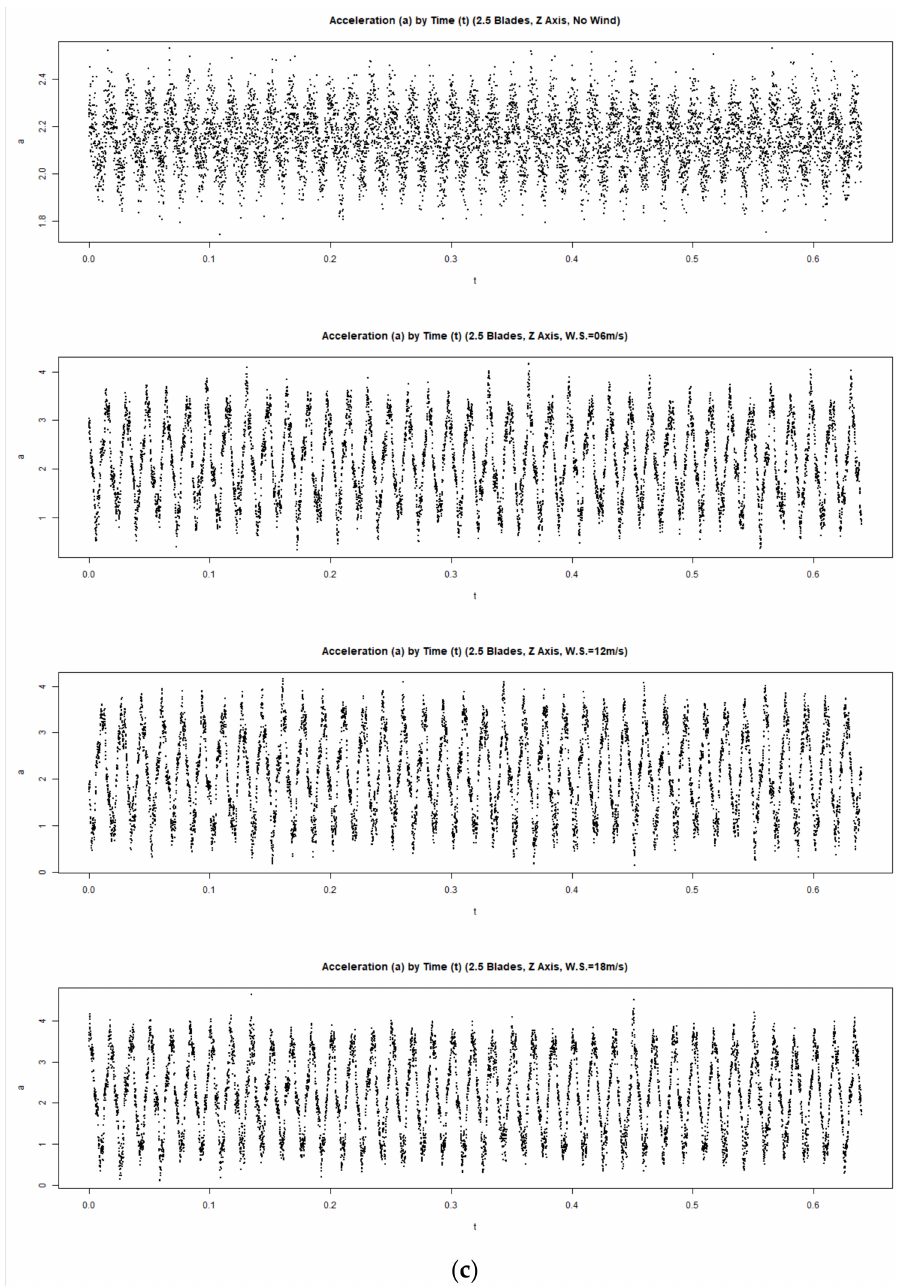
Figure A2. Acceleration signals recorded for the 2.5-blade (partially broken) turbine. ( a ) Data recorded along the X axis with different wind-speeds imposed. ( b ) Data recorded along the Y axis with different wind-speeds imposed. ( c ) Data recorded along the Z axis with different wind-speeds